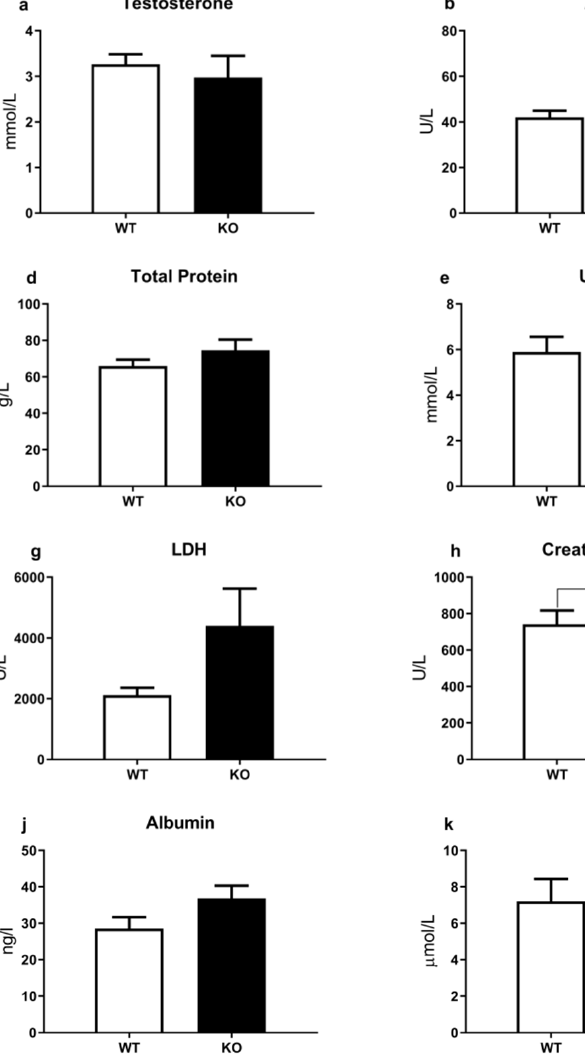
Figure 3. Comparative analysis of basic biochemical and hormonal parameters in the blood of TAAR1-KO and WT mice. ( a ) Testosterone, ( b ) alanine aminotransferase (ALT), ( c ) aspartate aminotransferase (AST), ( d ) total protein, ( e ) urea, ( f ) de Ritis ratio (AST/ALT), ( g ) lactate dehydrogenase (LDH), ( h ) creatine kinase, ( i ) alkaline phosphatase (ALP), ( j ) albumin, ( k ) total bilirubin (TB), ( l ) creatinine. The biochemical screening did not reveal significant differences in any of the demonstrated parameters. Only the creatine kinase comparative analysis shows minimal alterations (WT = 741.7 ± 75.02; KO = 463.5 ± 78.47). Data are mean ± SEM. * p <